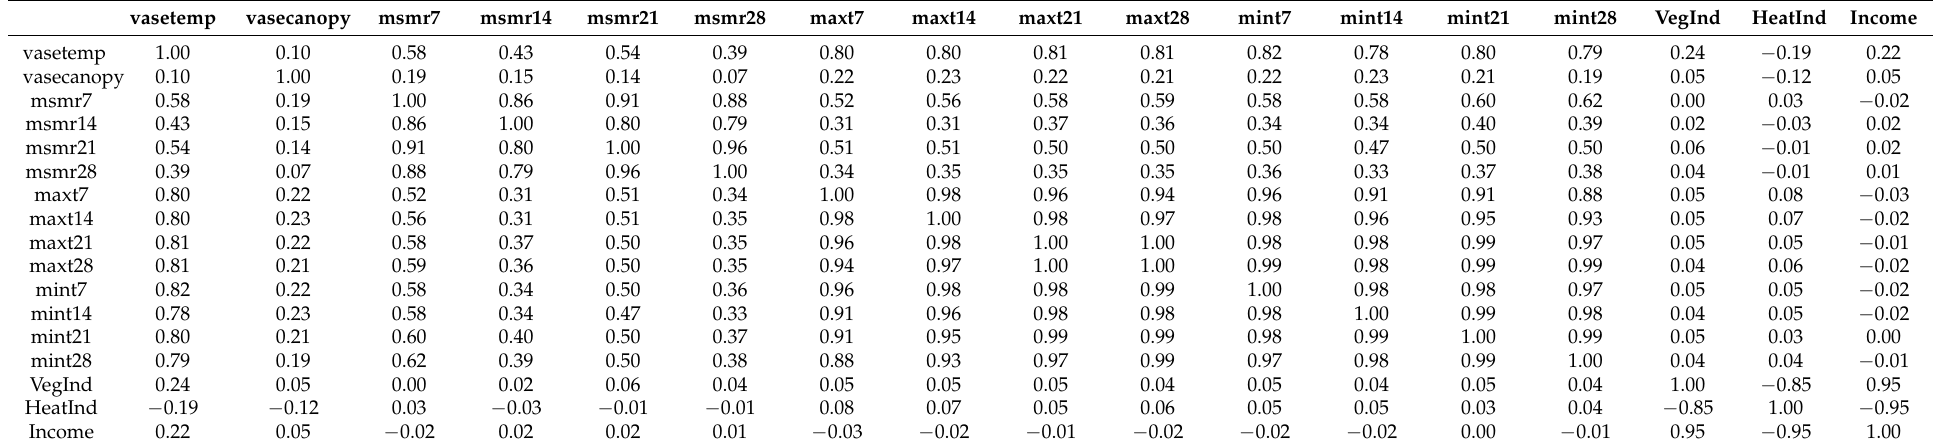
Table A1. Table showing pearson correlation coefficients among explanatory variables. Variable definition: msmr = moving sum rainfall, maxt = maximum temperature, mint = minimum temperature. Each variable was estimated at 28-day, 21-day, 14-day, and 7-day lags. Temperature is in degrees Celsius. Rainfall is in inches. VegInd = Vegetation Index, HeatInd = Heat Index.